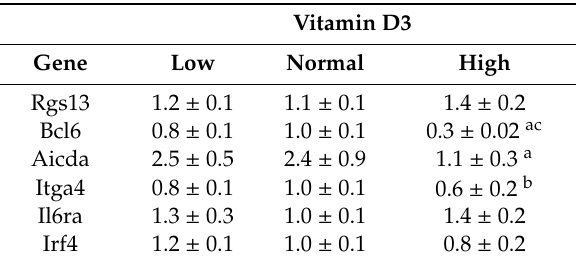
Table 1. Whole spleen gene